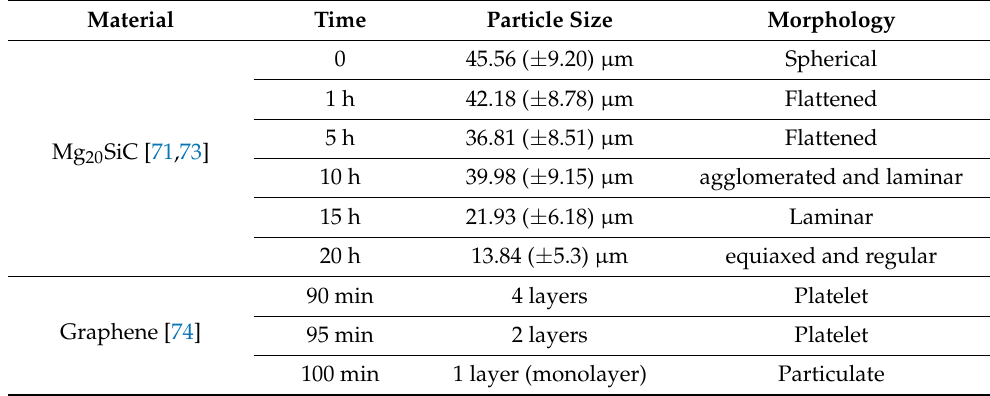
Table 1. Morphological and particle size dependence of composite as a function of time duration of milling.